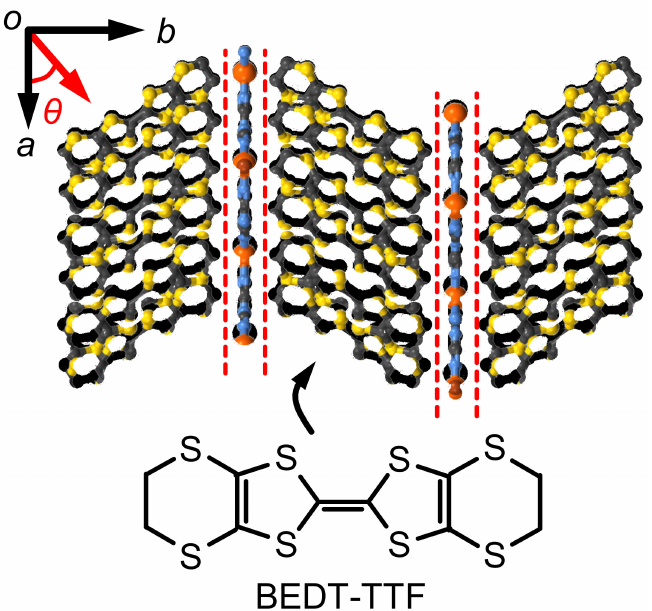
Figure 1. Crystal structure of κ -(BEDT-TTF) 2 Cu[N(CN) 2 ]Br. As divided by the red dashed lines, this material has the two-dimensional layered structure. θ represents the angle from a -axis to b -axis, used for the magnetic-field direction applied in this